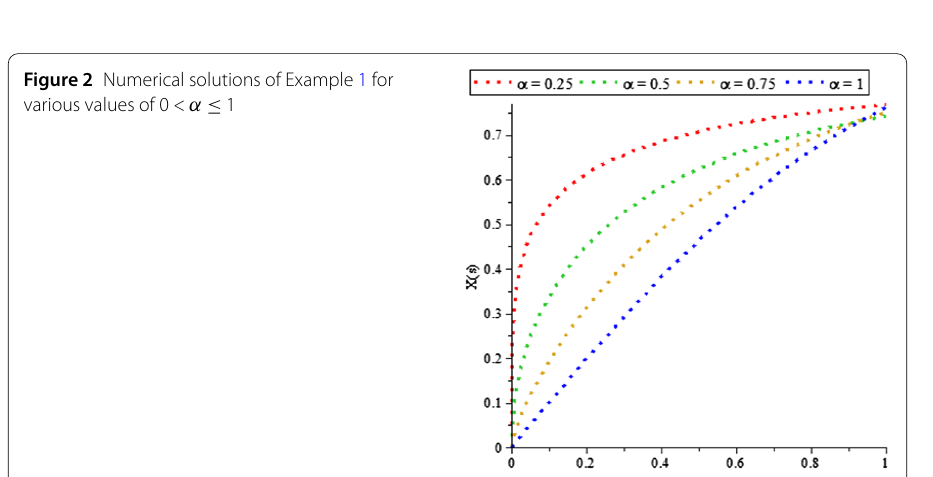
Figure 2 Numerical solutions of Example 1 for various values of 0 < α ≤